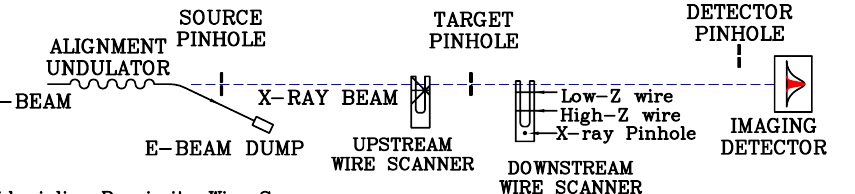
FIG. 7. (Color) The upstream wire scanner demonstrates its fiducialization near a target pinhole using x rays by scanning the wire across the x-ray beam after aligning the x-ray pinhole. The downstream wire scanner demonstrates that either an integral high- Z x-ray wire or an x-ray pinhole with known distance from the low- Z electron-beam wire can be used as x-ray beam fiducialization